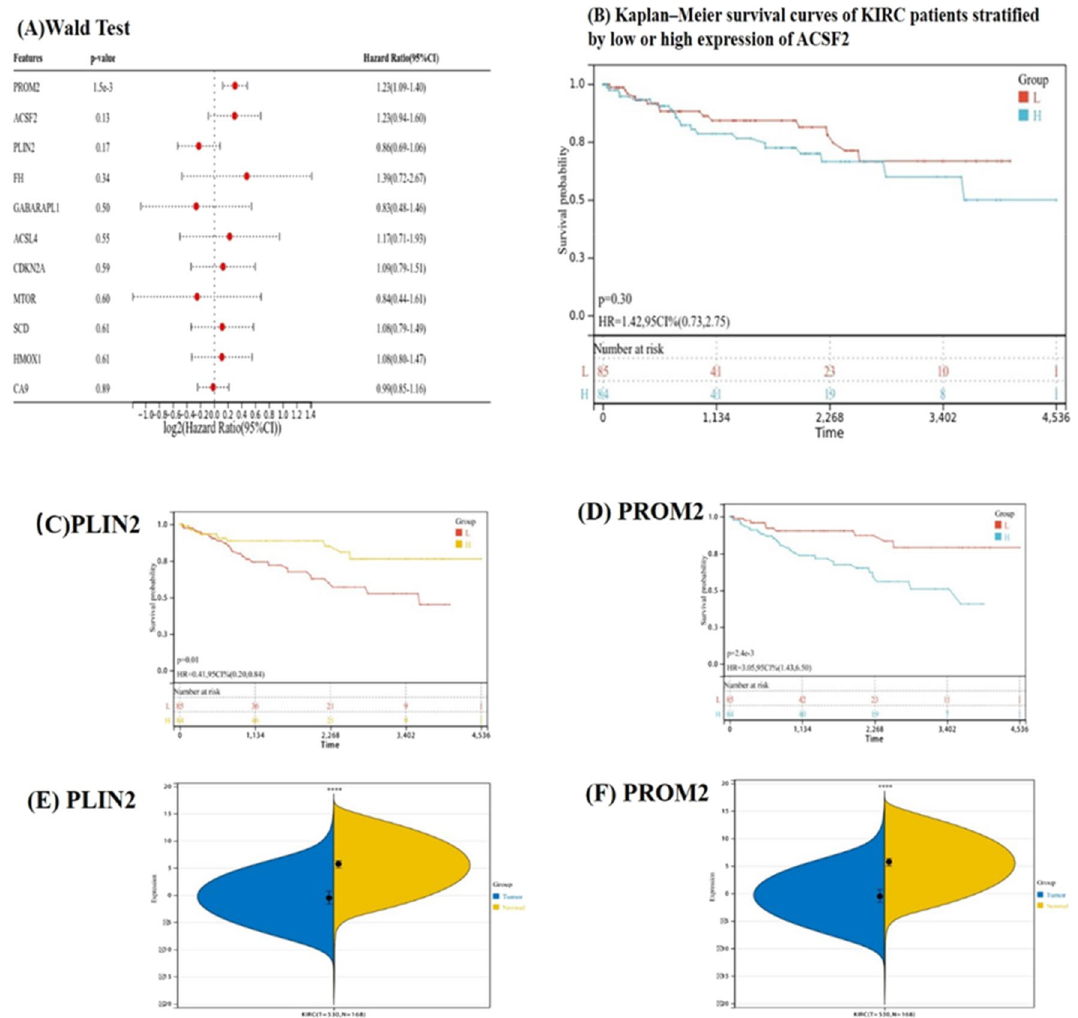
Figure 9. Survival analysis and validation of hub genes. ( A ) Wald Test. ( B ) Kaplan–Meier survival curves of patients with KIRC stratified by low or high expression of PLIN2 . ( C , D ) Kaplan–Meier survival curves of patients with KIRC stratified by low or high expression of PLIN2 ( C ) and PROM2 (D). (E–F) Differences in expression of the PLIN2 ( C ) and PROM2 ( D ) genes between normal and tumor tissues. * P < 0.01.